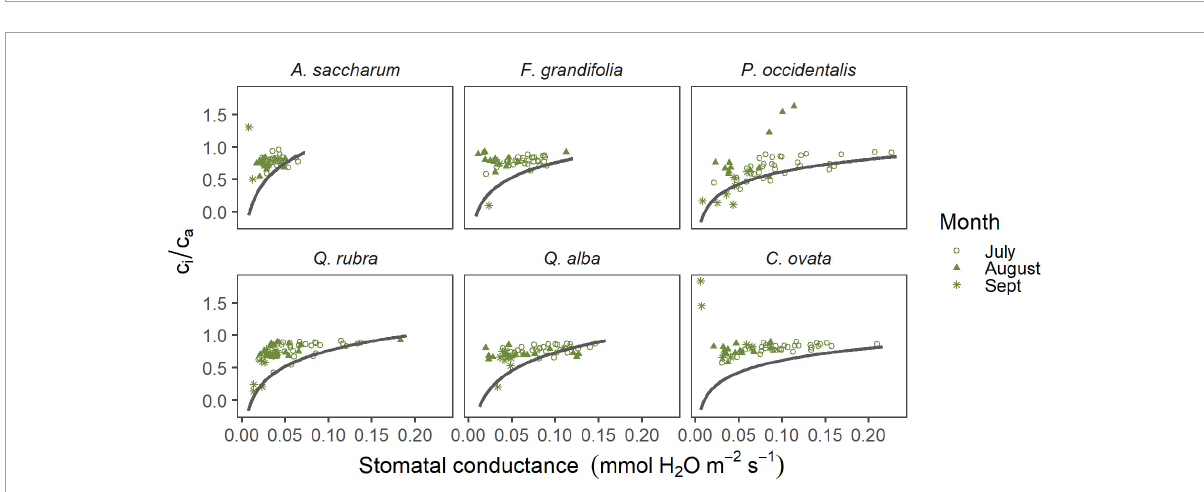
FIGURE3 Response of c i / c a to the seasonal decline in stomatal conductance for each species. The curve represents the theoretical response if stomatal conductance was the only limitation to photosynthesis; departures from the curve at low conductance values indicate nonstomatal limitation (Brodribb, 1996). Curves are fit to the respective range of conductance values for each species. Each data point represents a single leaf at a single time